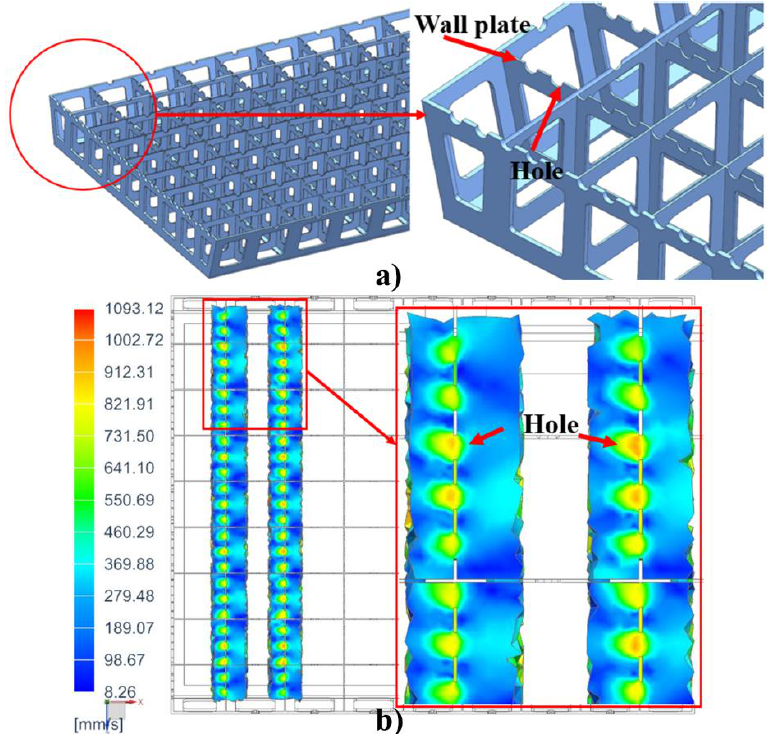
Figure 18. ( a ) Supporting frame structure of mold; ( b ) Fluid velocity distribution at the hole (unit: mm/s). Only the temperature distribution trend and temperature range for a large